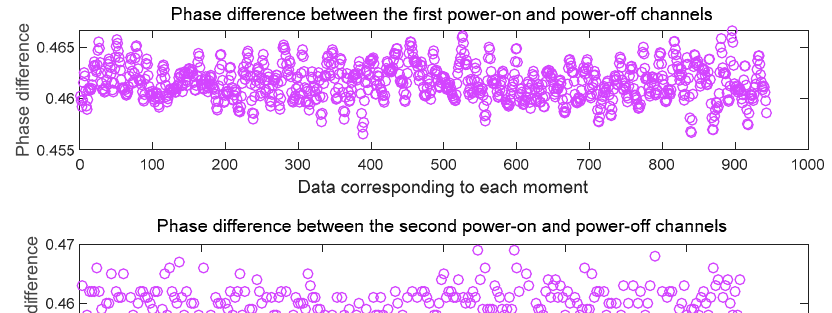
Figure 3. Wired environment test chart. Sensors 2020 , 18 , x FOR PEER REVIEW